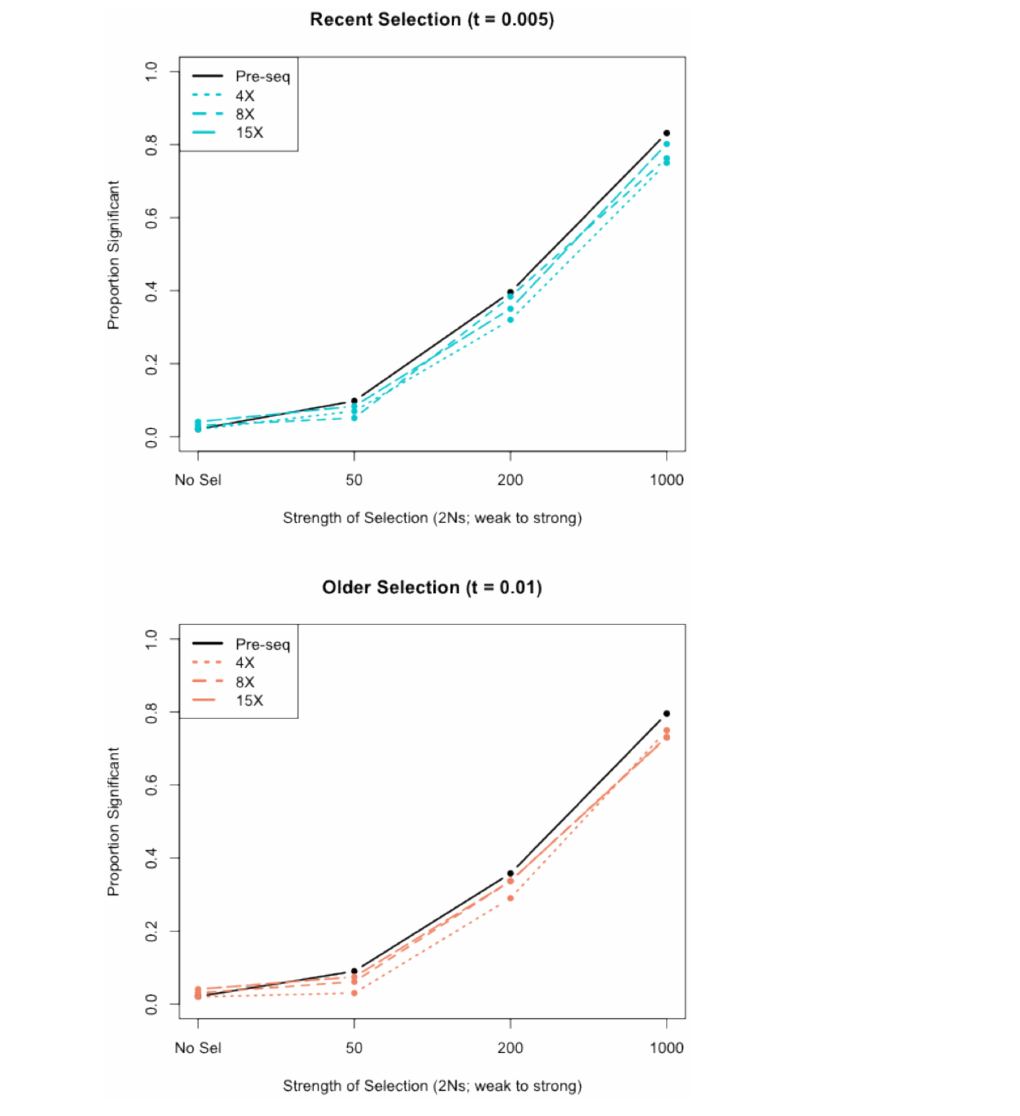
FIGUREA3 |The power to detect selective sweeps before and after simulated next-generation sequencing. The proportion of statistically significant detections of positive selection was calculated from simulations of a 30-kb region of 30 chromosomes with one selective sweep. Simulations were compared to a null distribution generated by neutral simulations and